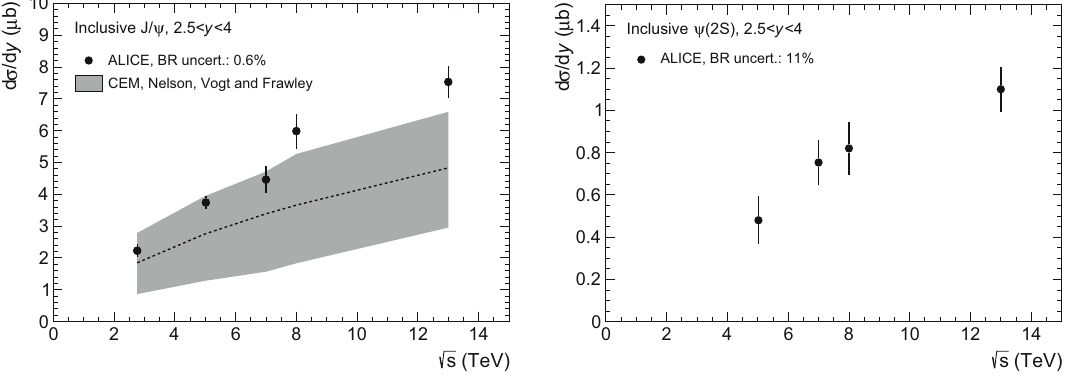
√ s . Vertical lines correspond to the quadratic sum of the